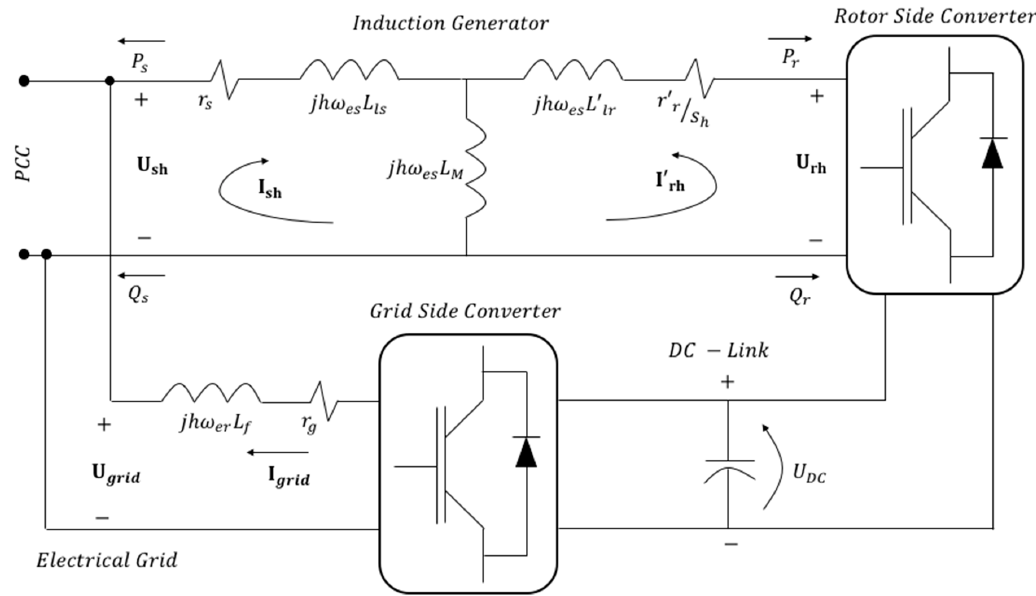
Figure 7. Interconnection diagram of the DFIG with the electrical grid.